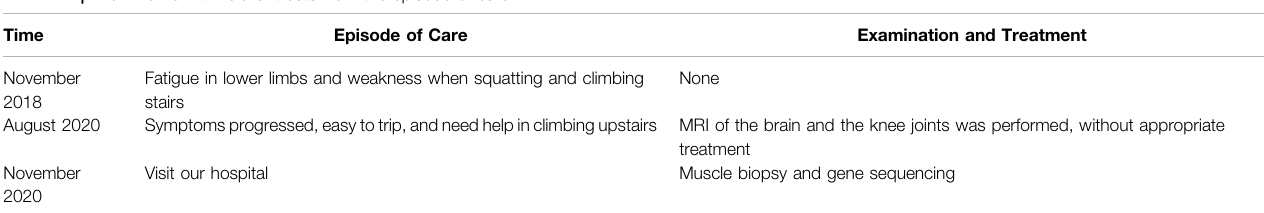
TABLE 1 | The timeline with relevant data from the episode of